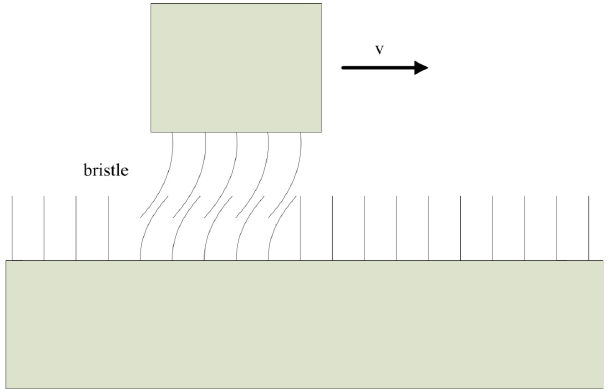
Figure 7. Bristle theory (Canudas de Wit et al.,